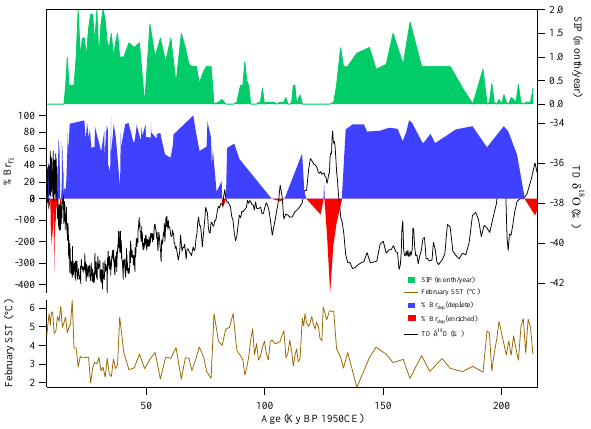
Fig. 4. %Br fi is plotted with sea ice presence (SIP, green area, ex- pressed as month/year) and February sea-surface temperature (red line) (Crosta et al., 2004). Talos Dome δ 18 O is also shown. The red areas indicate Br − enrichment (i.e. negative %Br fi ) while blue areas indicate bromide depletion.